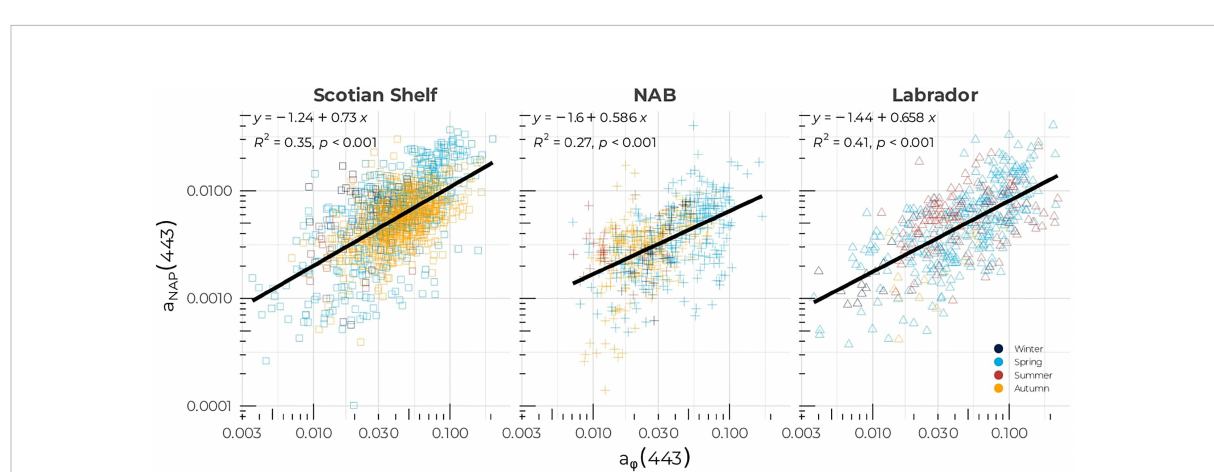
FIGURE 5 Non-algal particulate absorption coef fi cient at 443 nm, a NAP (443), as a function of a f (443) for the Scotian Shelf (left panel), the Northwest Atlantic Basin (middle panel), and the Labrador Sea (right panel). The solid black lines correspond to the linear regression of a NAP (443) versus a f (443). Symbols are color-coded according to season as in Figure